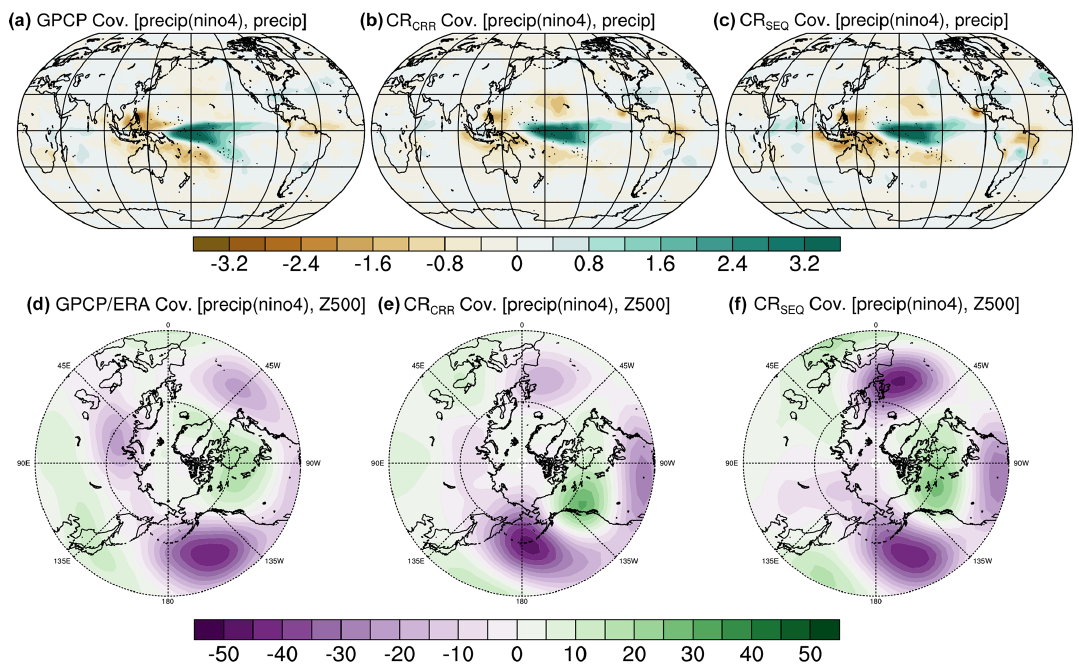
Figure 17. Covariance (cov(mmd − 1 , mmd − 1 )) of DJF (December–January–February) precipitation anomalies with the normalized time series of precipitation anomaly in the Niño4 region for (a) GPCP observations as well as the (b) concurrent and (c) classical radiation experiments. Covariance (cov(m, mmd − 1 )) of DJF 500hPa geopotential height anomalies in the Northern Hemisphere with the normalized time series of precipitation anomaly in the Niño4 region for (d) ERA-Interim, (e) concurrent, and (f) classical radiation